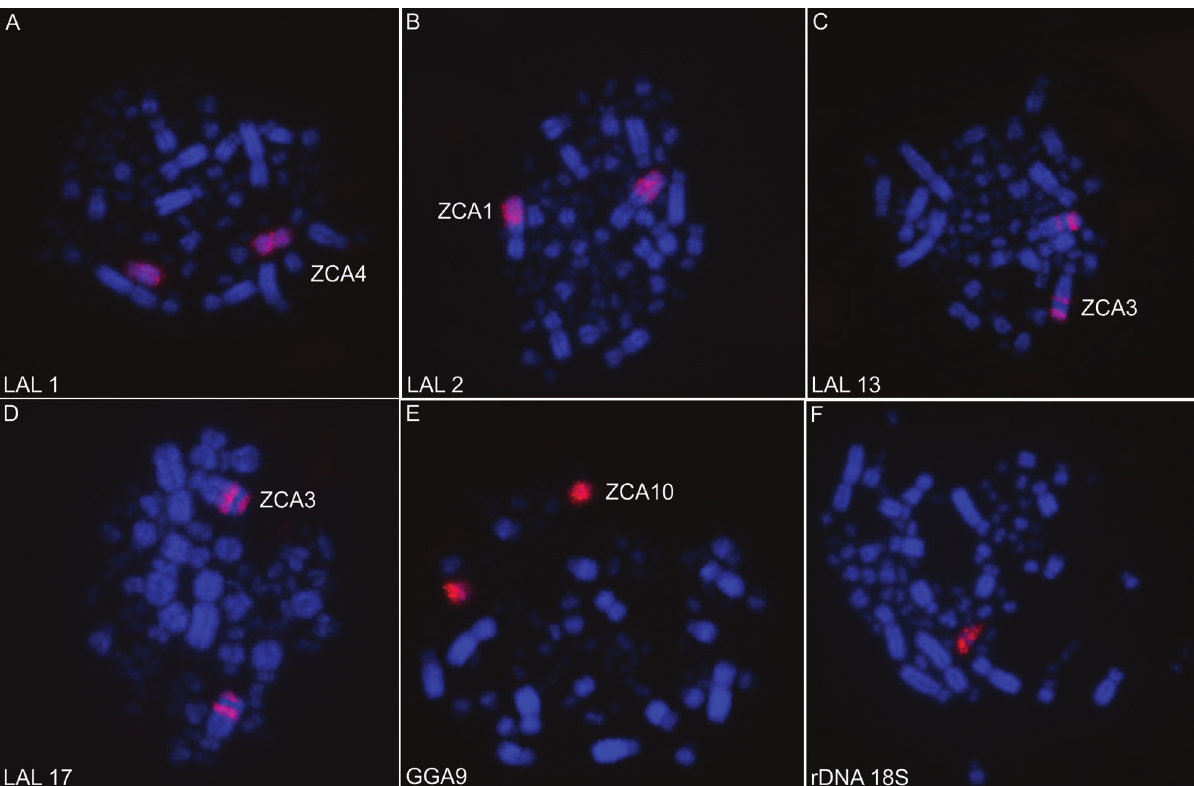
Figure 2 - Chromosome hybridization patterns with Leucopternis albicollis (LAL) probes (A: LAL1; B: LAL2; C: LAL13; D: LAL17), Gallus gallus (GGA) probes (E: GGA9) and 18S rDNA probes (F) onto rufous-collared sparrow metaphases.